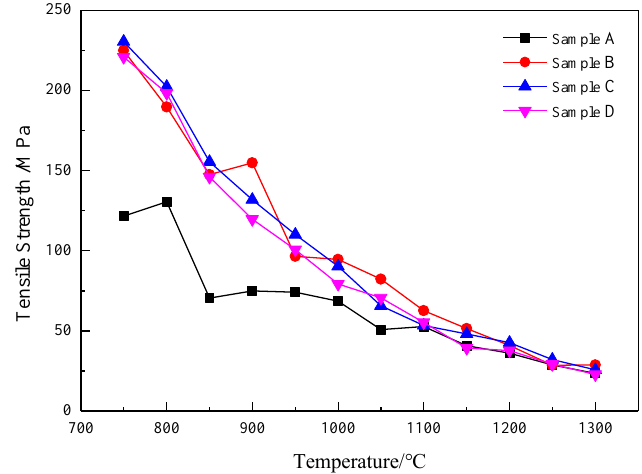
Figure 5. Tensile strength curve of high-rise structural steel with different Nb content. (2) Yield strength curve